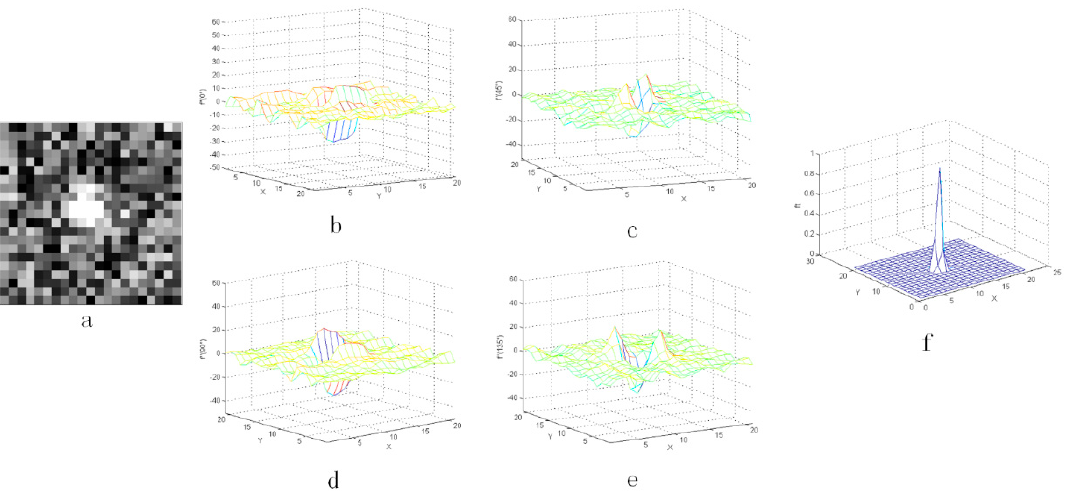
Figure 10. The result with the noise whose coefficient Q is 10%: ( a ) the star image with added random noise and ( b – e ) the three-dimensional distribution of the second-order derivative, ( f ) the output value f t after CMLCM processing.